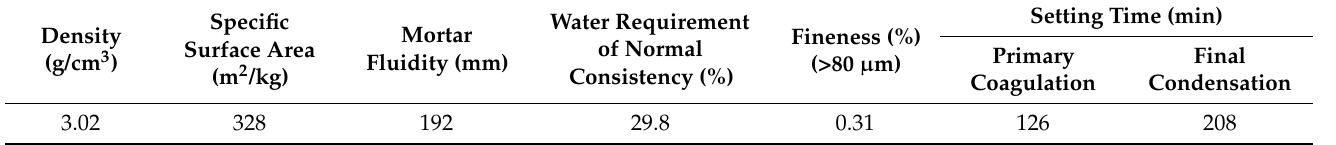
Table 2. Physical property index of the